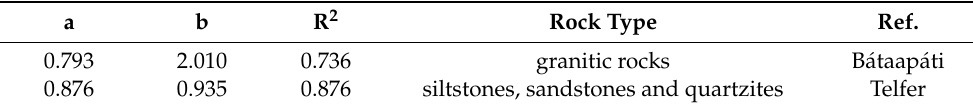
Table 2. Equations of the existing correlations between RMR 89 and GSI in the studied projects.